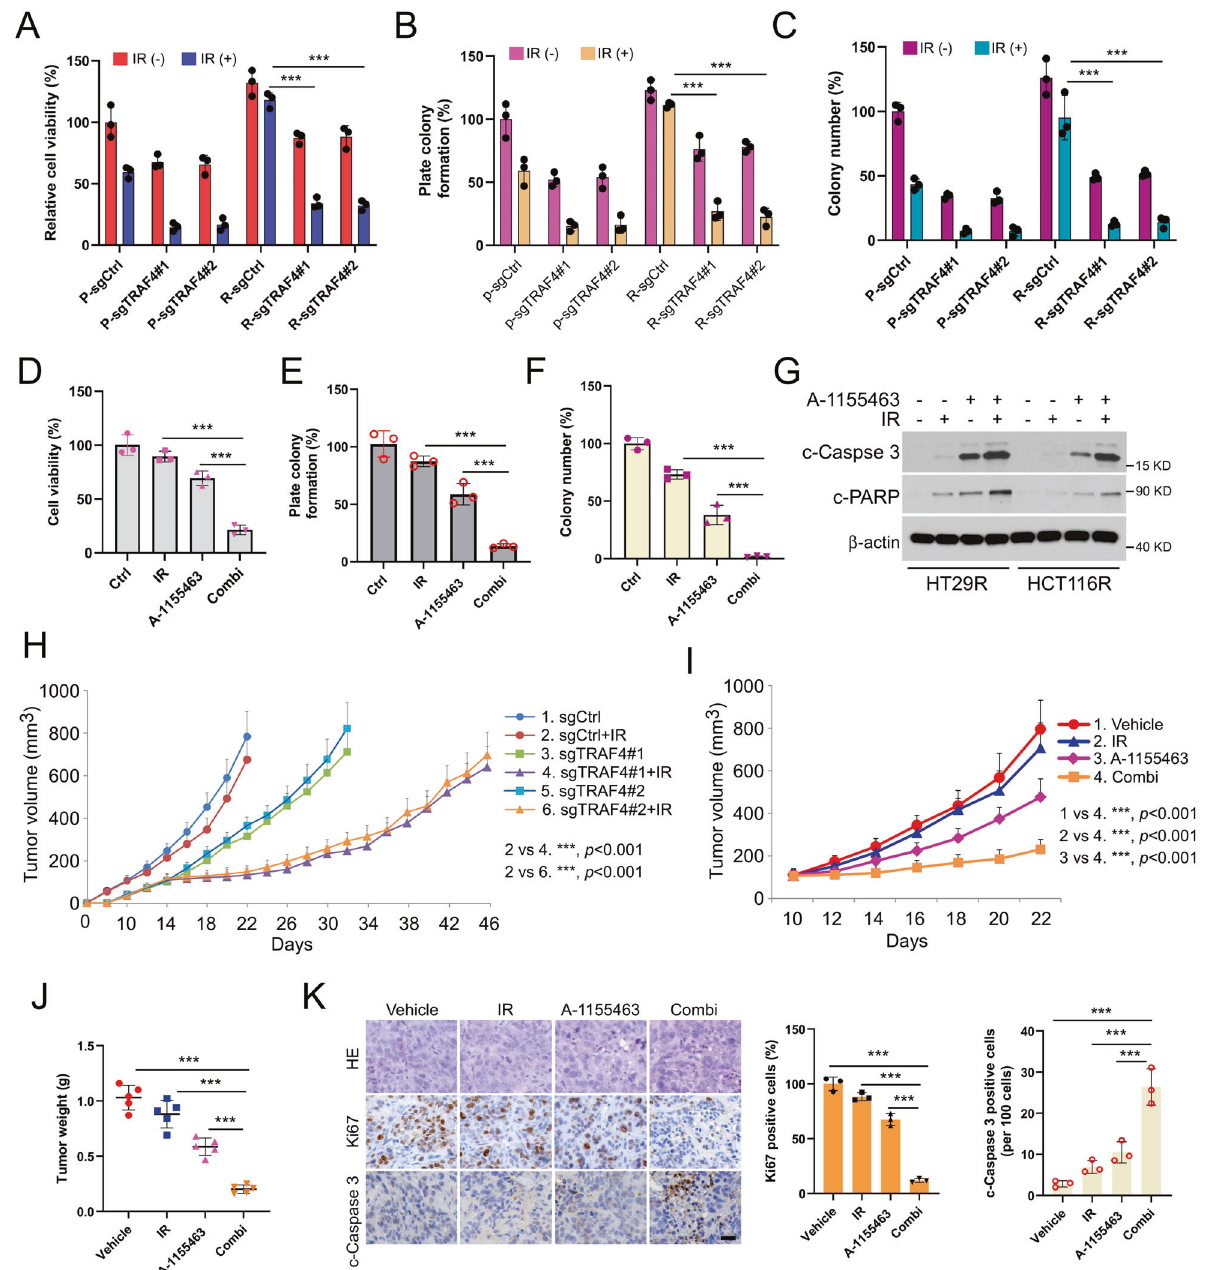
Fig. 8 Inhibiting the TRAF4/ Bcl-xL axis overcomes radioresistance in colorectal cancer cells. A – C Parental and radioresistant HT29 cells expressing sg-Ctrl or sg-TRAF4 were treated with or without IR (4 Gy). Cell viability and colony formation were determined by MTS ( A ), plate colony formation ( B ), and soft agar ( C ) assays. P, parental cells; R, resistant cells. *** p < 0.001. D – G HT29R cells were treated with A-1155463 inhibitor (2 µM), IR (4 Gy), or a combination of both for 72 h. MTS assay was used to determine the cell viability ( D ), plate colony formation assay to analyze the cell proliferation ( E ), and soft agar assay to assess the anchorage-independent cell proliferation ( F ). Immunoblotting to detect the expression of cleaved-caspase 3 and cleaved-PARP ( G ). *** p < 0.001. H. Average tumor volume of HT29R-sgCtrl and -sgTRAF4 xenograft tumors treated with or without IR (2 Gy/twice per week); n = 5 mice per group. I-K. Xenograft tumors from HT29R cells were treated with the vehicle control, A-1155463 (5 mg/kg/every 2 days), IR (2 Gy/twice per week), or a combination of both; n = 5 mice per group. Average tumor volume ( I ) and tumor weight ( J ) were recorded, and tumor sections were subjected to IHC staining of Ki67 and cleaved-caspase 3 ( K ). For K, left, representative image; right, quali fi cation. *** p < 0.001. Scale bar, 25 μ m. TRAF4 TNF receptor-associated factor 4, IR ionizing radiation, Ctrl control, P parental cells, R resistant mediated JNK/c-Jun signaling activation. Bcl-xL overexpression radiation effects. By contrast, high expression of Bcl-xL promotes the reversed the apoptotic phenotype in radiation-treated TRAF4-null propagation of cancer cells with a radiation-resistant phenotype by CRC cells, and combination with Bcl-xL inhibitor overcame radio- enhancing alternative end-joining and homologous recombination resistance. This result provides new insights to elucidate the cause of repair during double-strand break treatment [38]. The current study radioresistance in colon cancer. identi fi ed Bcl-xL as a TRAF4 downstream gene regulated by TRAF4-